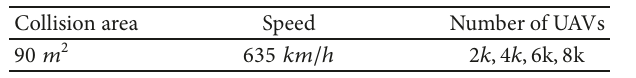
Table 10: Core parameters of